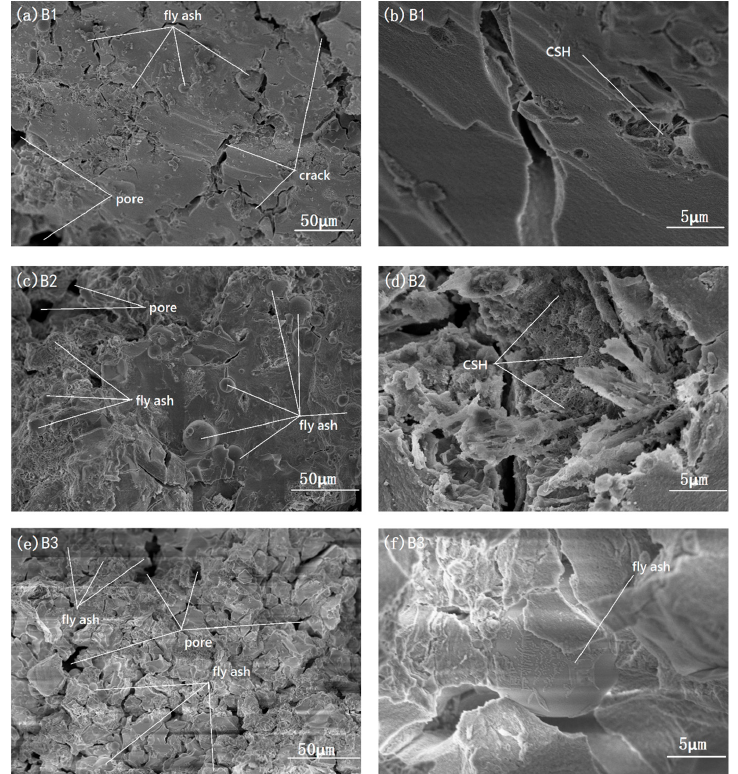
Figure 10. Photographs of SEM of the specimens under different fly ash content.